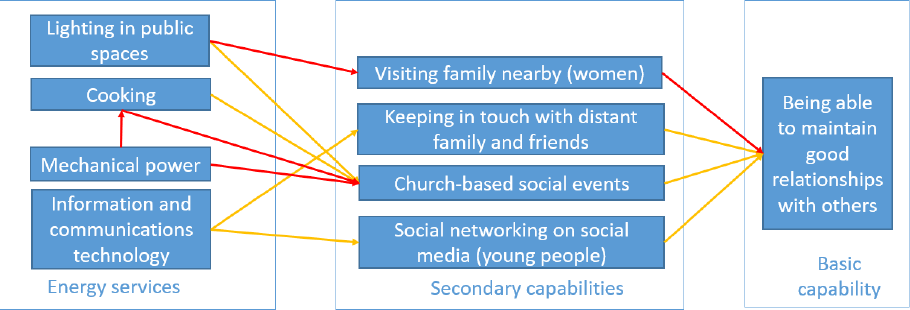
Figure 6. Connections between energy services, secondary capabilities, and ability to maintain relationships.